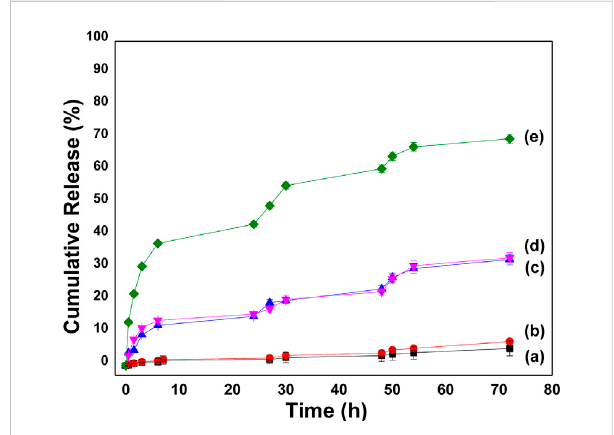
FIGURE 7 In vitro cumulative release pro fi les of 5-FU from (a)SBA@3N in